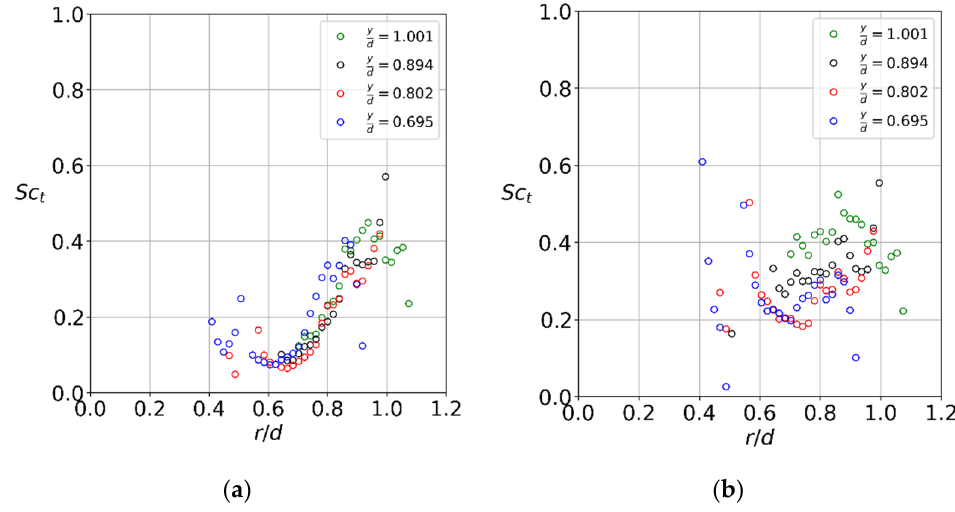
Figure 15. Turbulent Schmidt number for ( a ) total ( b ) stochastic turbulent fluctuations for high-swirl jet.